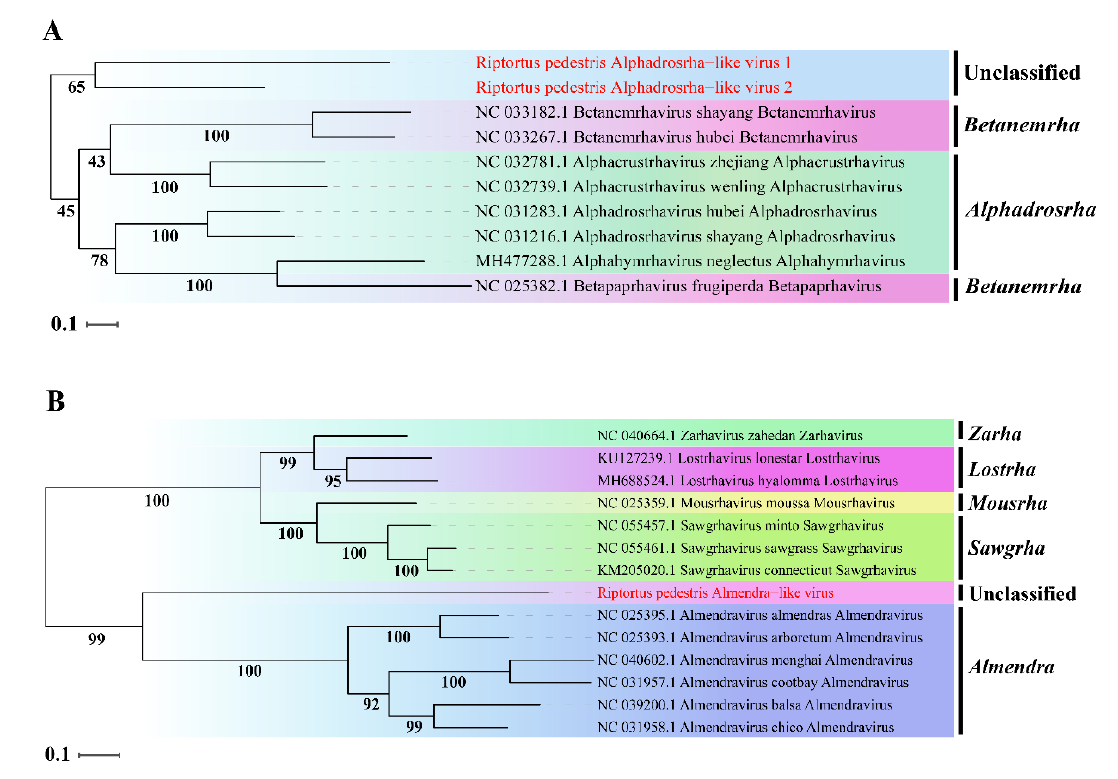
Figure 2. ML-phylogenetic tree of three insect-specific viruses identified in R. pedestris . Phylogenetic tree based on the RdRp domain of Riptortus pedestris alphadrosrha-like virus 1 (RpALv1), Riptortus pedestris alphadrosrha-like virus 2 (RpALv2) ( A ) and Riptortus pedestris almendra-like virus (RiALv) ( B ) were constructed using maximum likelihood method. ISVs identified in this study are shown in red font. Nodes with bootstrap values >50% are placed over each node of the tree. Scale bars on the left represent percentage divergence.